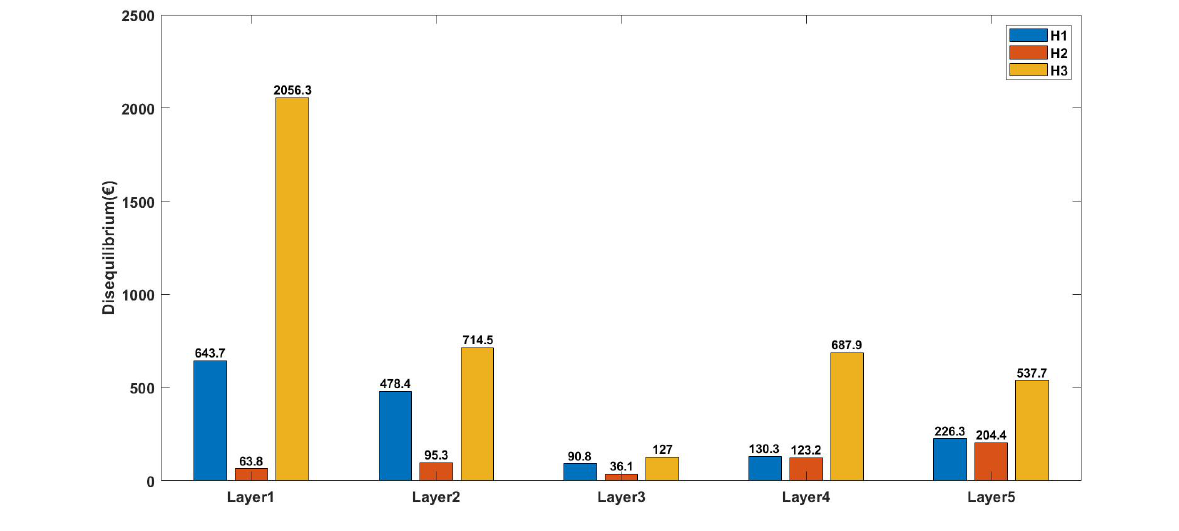
Figure 16. The ESC total profits obtained from the re-inputs of H 1 , H 2 and H 3 .